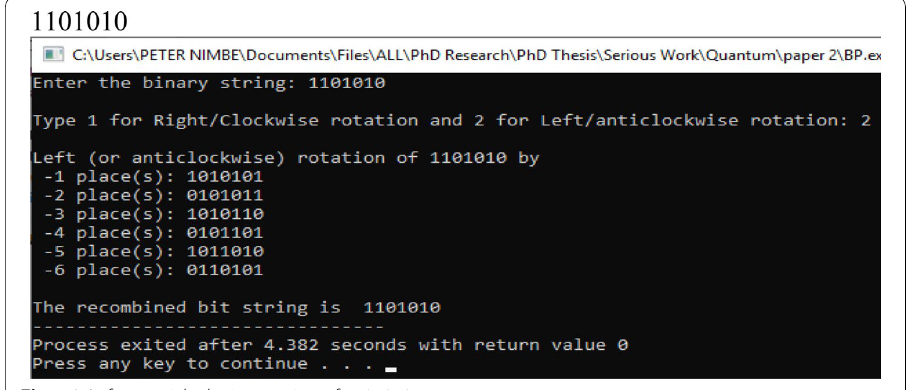
Fig. 16 Left or anticlockwise rotation of 1101010